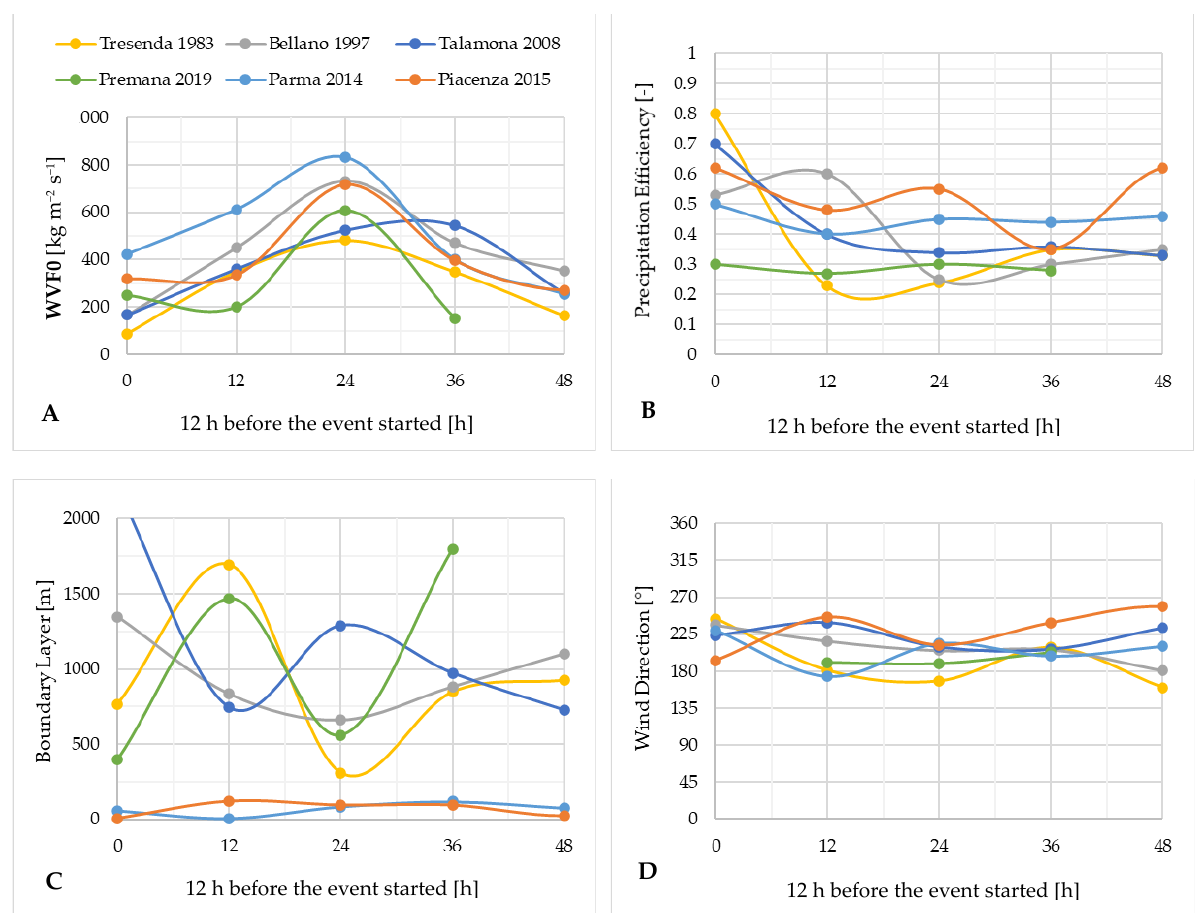
Figure 4. Initial conditions retrieved from radiosonde data regarding ( A ) the WVF0 , ( B ) the PE, ( C ) the BL, and ( D ) the WD. As can be seen, there is a certain variability of WVF0 that, during the most intense phase, has values higher than 400 kg m −2 s −1 . PE is less dispersed and fluctuates around 0.3 – 0.4 values, typical for this type of precipitation. BL is much more dispersed and appears significant for Alps cases rather than Apennine cases, where its influence is negligible. WD comes from a south- west direction in all cases studied. The variable evolution was studied according to the radiosonde data 24 h in advance with respect to the critical phase of the event (as can be appreciated by WVF0 fluctuation). For 1983 and 1997 events, we have depicted only the most intense phase, even though the rainfall lasted for 60 h and 96 h, respectively.